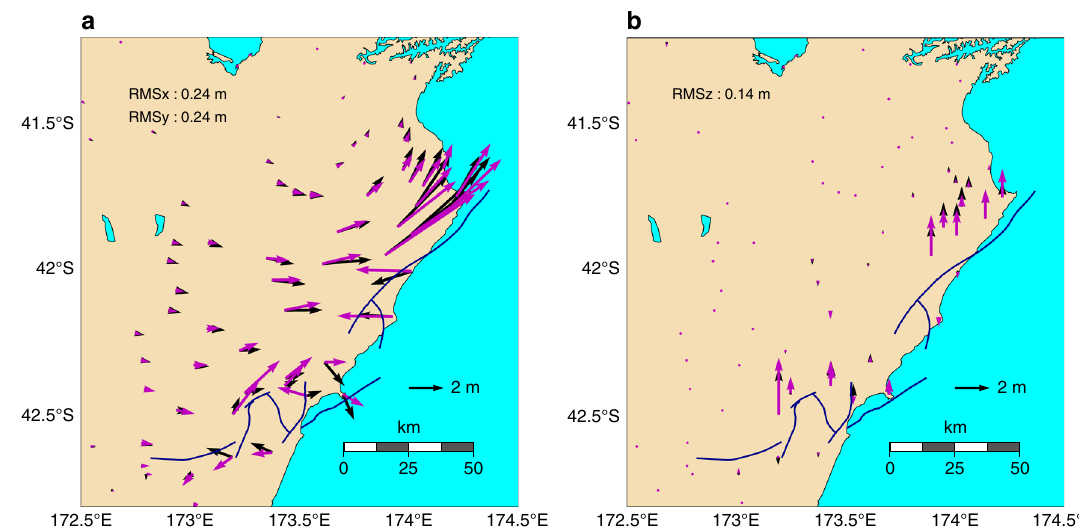
Fig. 7 Comparison of observed and synthetic static ground deformation. Shown are observed (black) and modeled (magenta) horizontal ( a ) and vertical ( b ) ground displacement at Global Positioning System (GPS) stations. Root-mean-square (RMS) mis fi ts are provided for each component. The observed ground displacements at the locations of the GPS stations are taken from Hamling et al. 1